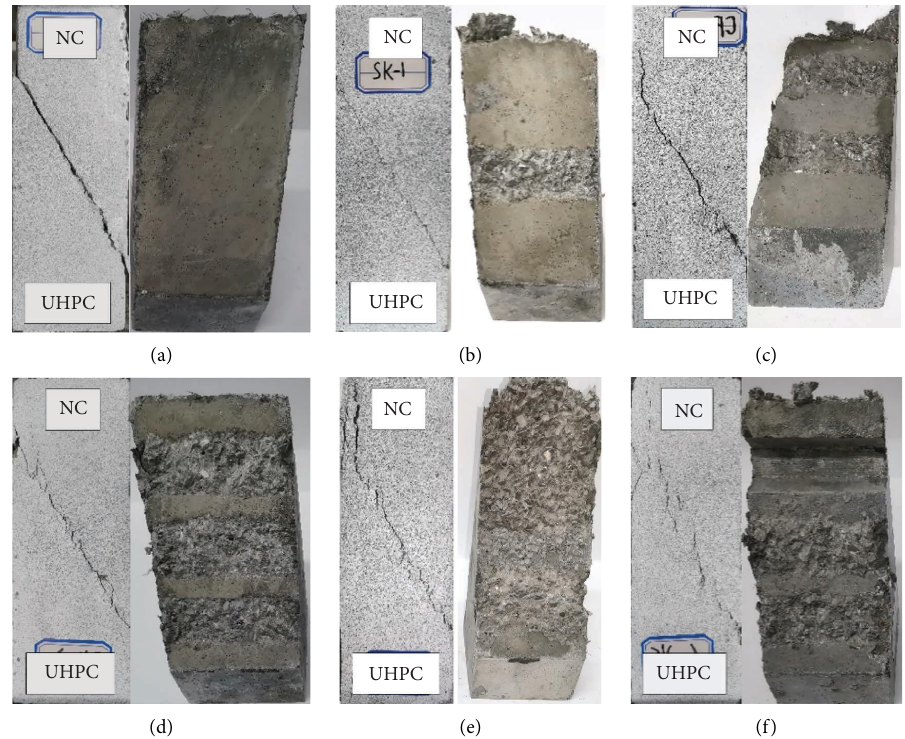
Figure 4: Failure patterns of the specimens. (a) Specimen K0-NA-40. (b) Specimen K1-NA-40. (c) Specimen K2-NA-40. (d) Specimen K3- NA-40-3. (e) Specimen K2-NA-3. (f) Specimen